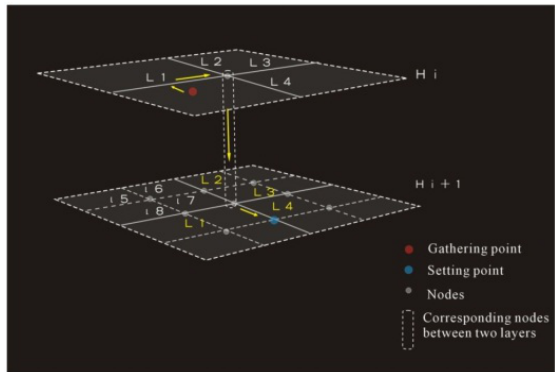
Figure 4. Detailed